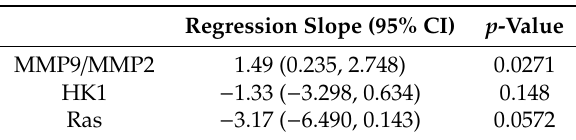
Table 4. Linear model of change in Body Mass Index (BMI) by change in protein level from baseline visit to post metformin visit.